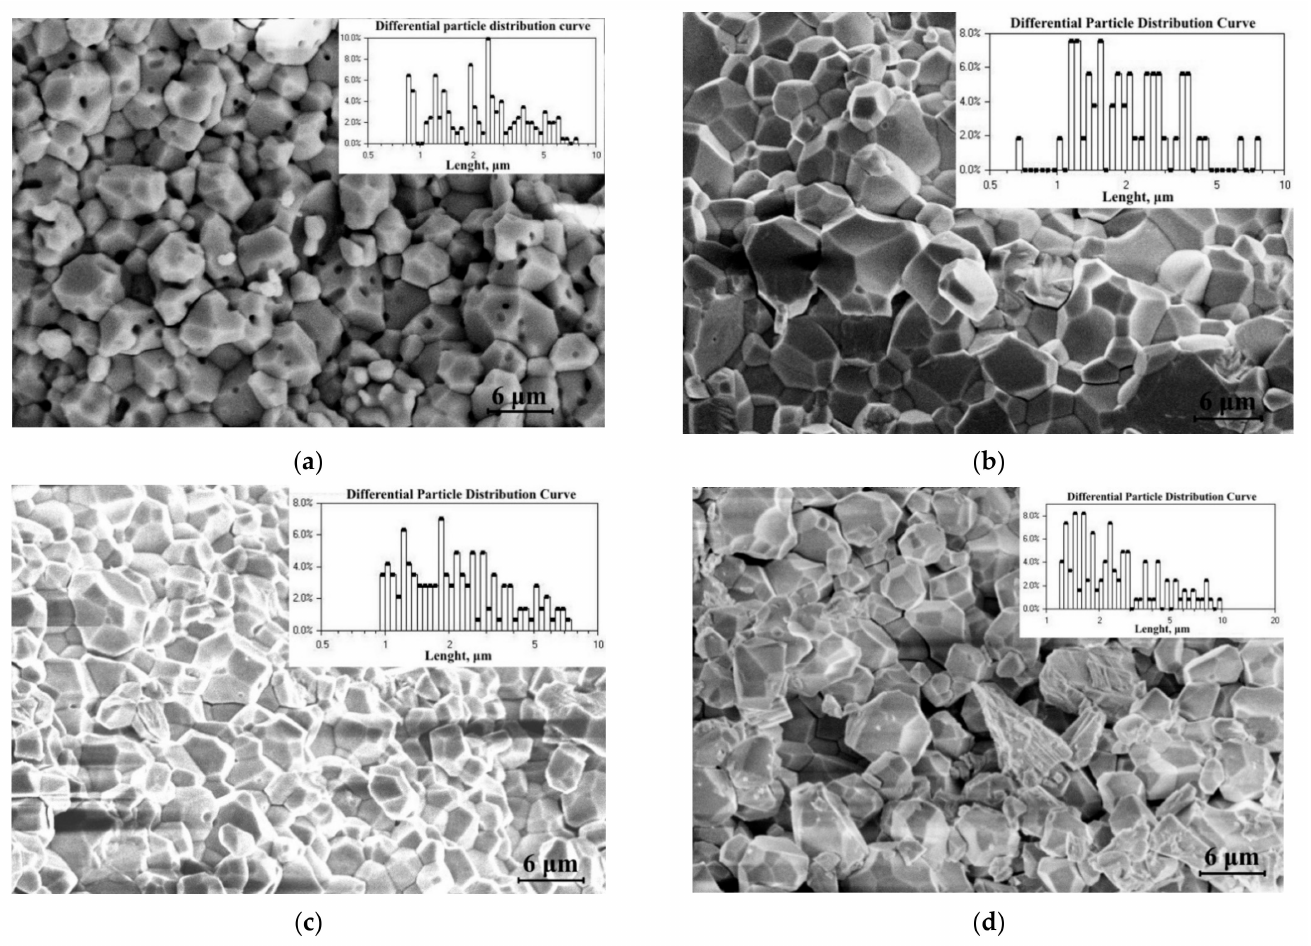
Figure 2. Microstructure and size composition of Gd 0.96 Eu 0.01 Sm 0.01 Tb 0.01 Er 0.01 Nb 0.9 Ta. 0.1 O 4 ceramic samples ( a ) 1; ( b ) 2; ( c ) 3; ( d )